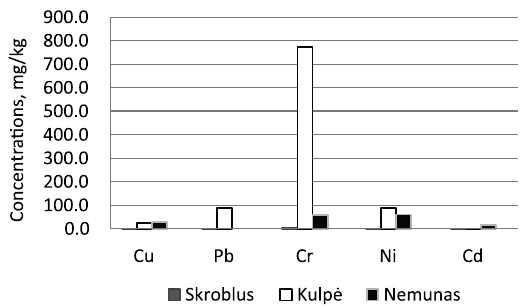
Fig. 6. HM concentrations in bottom sediments of the most contaminated and the cleanest Lithuanian rivers